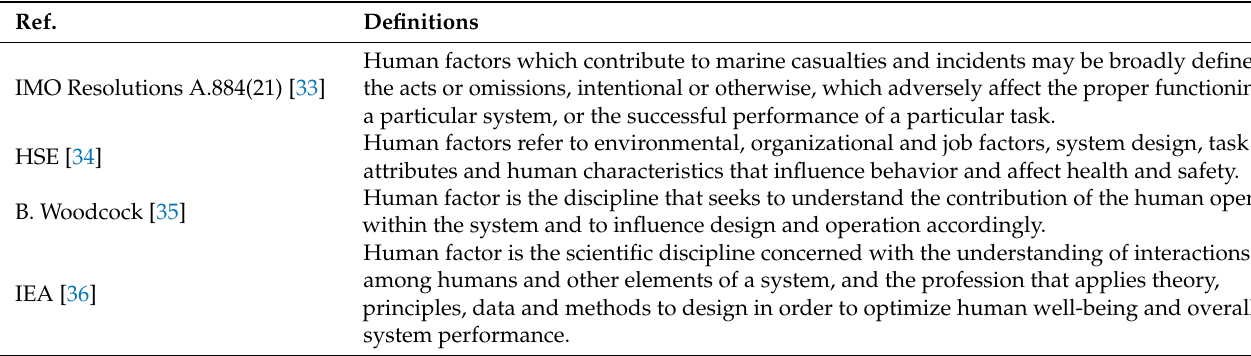
Table 2. Definitions of human